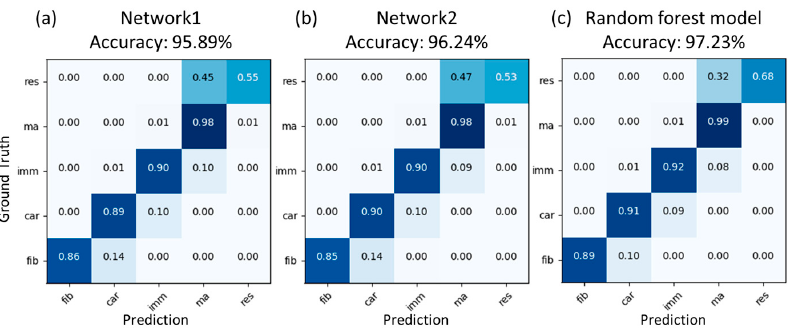
Figure A4. Accuracy score and confusion matrix of classification results by ( a ) Network 1, ( b ) Net- work 2, and ( c ) the random forest model.